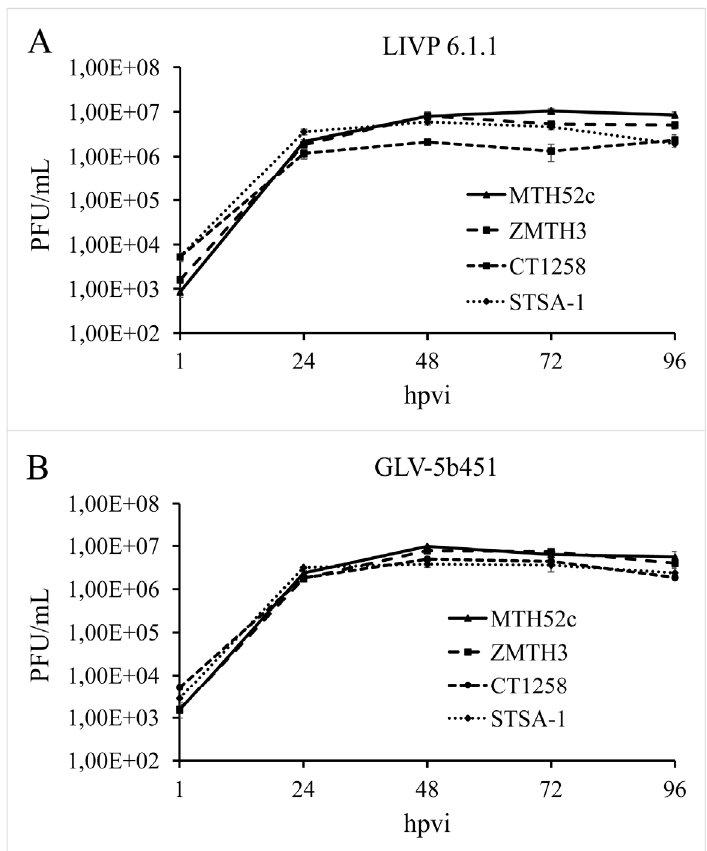
Figure 3. Replication capacity of the vaccinia virus strains LIVP 6.1.1 ( A ) and GLV-5b451 ( B ) in different canine cancer cell lines. For the viral replication assay, MTH52c, ZMTH3, CT1258 or STSA-1 cells grown in 24-well plates were infected with either LIVP 6.1.1 or GLV-5b451 at an MOI of 0.1. Cells and supernatants were collected for the determination of virus titers at various time points. Viral titers were determined as pfu per ml in triplicates by standard plaque assay in CV-1 cell monolayers. Averages plus standard deviation are plotted. The data represent three independent experiments.